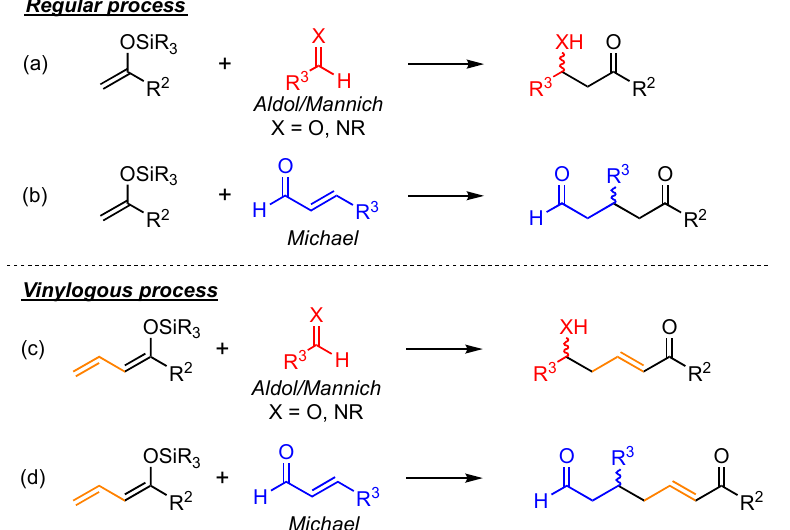
formation reactions.